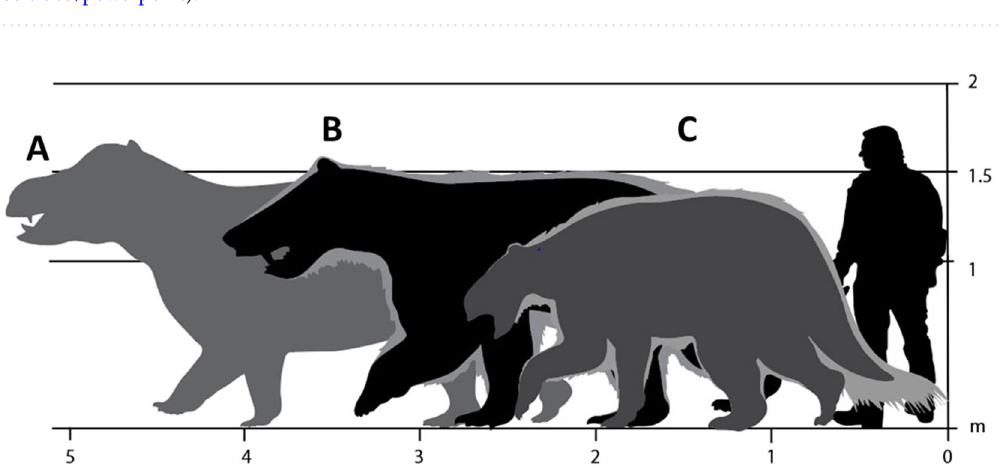
Figure 8. Reconstructed track maker candidates for size comparison. ( A ) Paleocene Coryphodon proterus (Yale Peabody Museum specimen VPOU.016130, with a 62 cm long skull), based on measurements of Eocene C. radians 18 ; ( B ) Titanoides primaevus based on skeletal reconstruction 19 and scaled to holotype specimen (Yale Peabody Museum VPPU.016490); ( C ) Barylambda faberi based on mounted specimen displayed at the Field Museum of Natural History. Drawings made by A F-J W in Adobe Illustrator 2021 (version 25.2.1, https:// www. adobe. com/ produ cts/ illus trator.